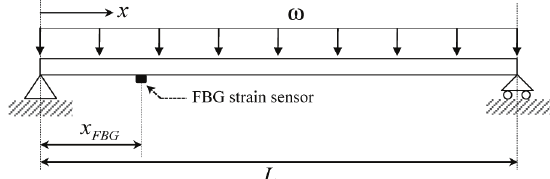
Fig. 2. Simply supported beam subjected to uniformly distributed